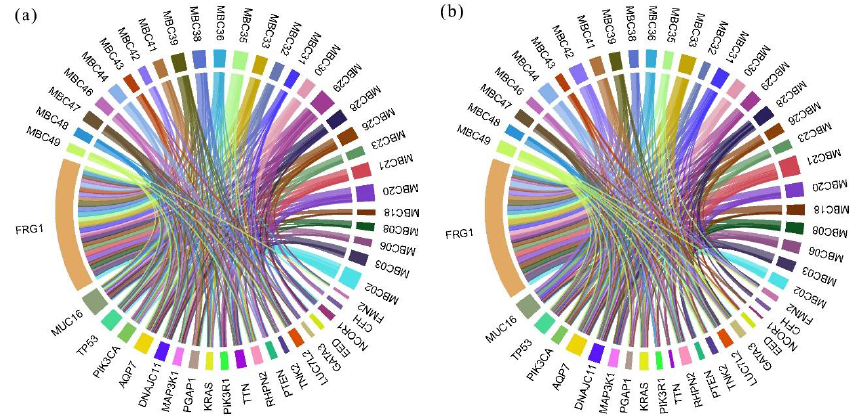
Figure 3. Distribution of ctDNA mutations before and after chemotherapy for all patients. Top 20 genes were shown. ( a ) ctDNA mutations at baseline. ( b ) ctDNA mutations after chemotherapy. Width of each part represents number of mutations detected in corresponding patients or genes.